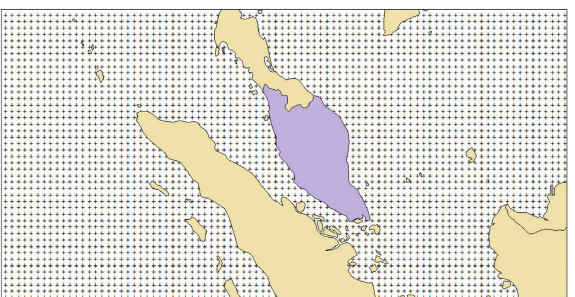
Figure 3: Climate domain considered for extraction of sea level pressure data for the prediction of rainfall in Peninsular